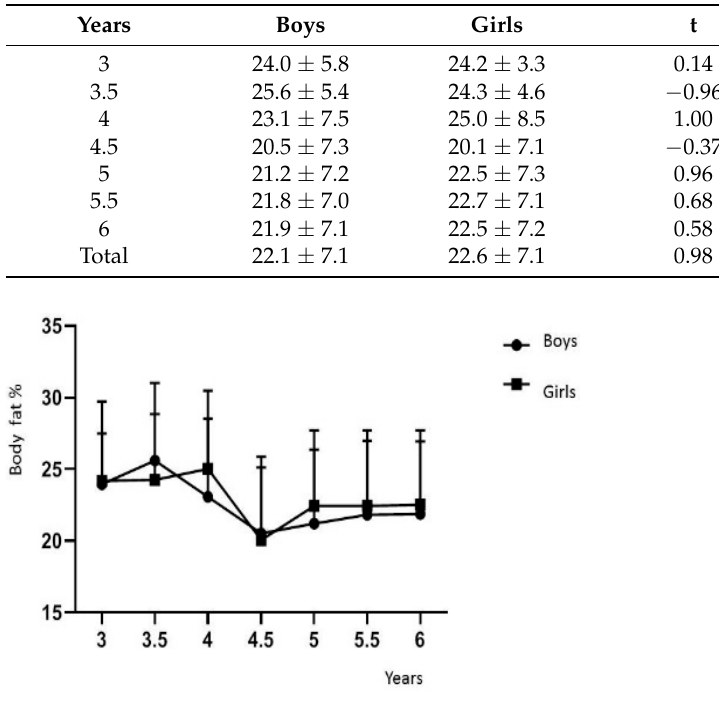
Figure 1. Body fat percentage of children aged 3~6. Figures 1 and 2 show that BMI and body fat percentage had the same downward trend with age.